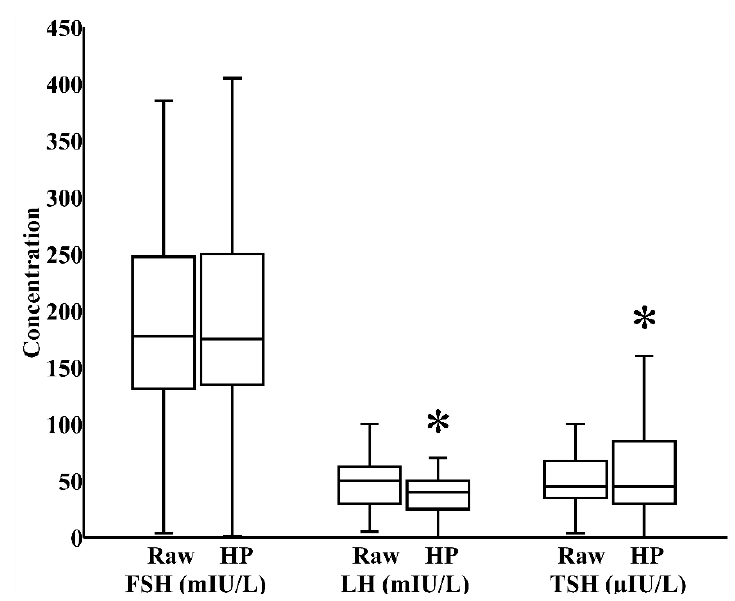
Figure 1. Impact of Holder pasteurization (HoP) on the concentrations of follicle-stimulating hormone (FSH), luteinizing hormone (LH), and thyroid-stimulating hormone (TSH) in breast milk donated to the Mother’s Milk Bank of Iowa ( N = 30). * p < 0.05 versus raw milk.